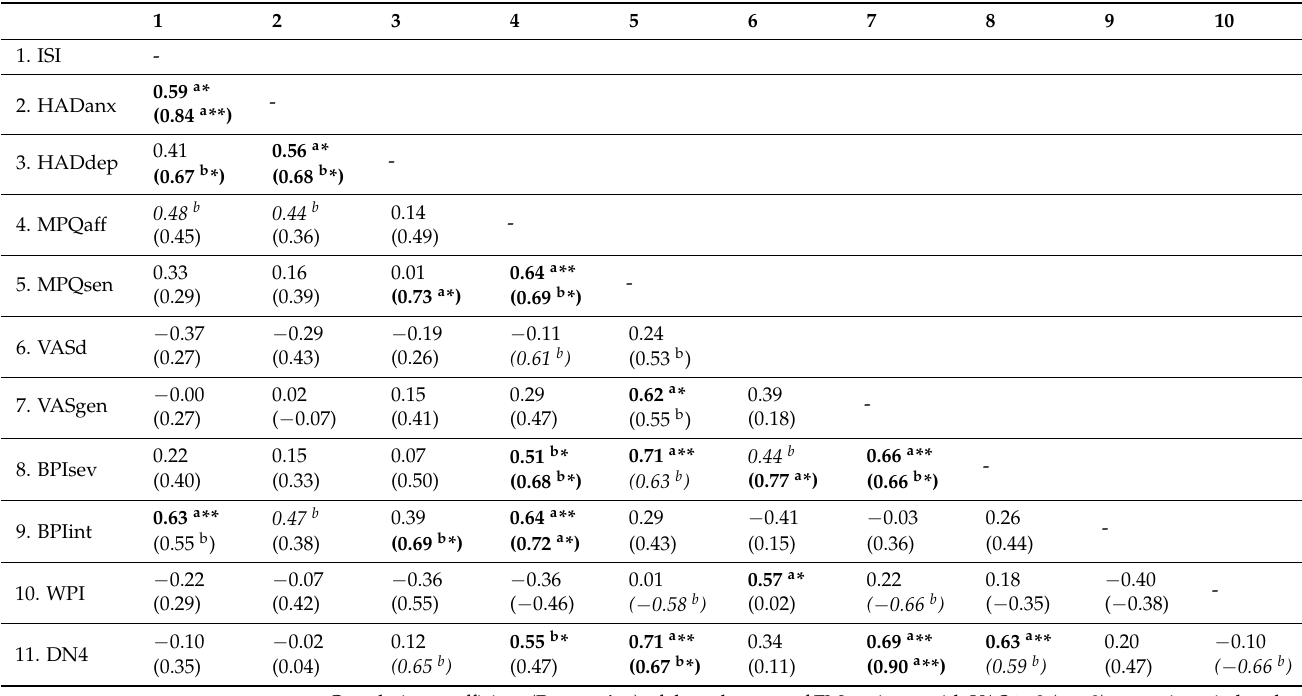
Table 2. Correlations between clinical scores in FM